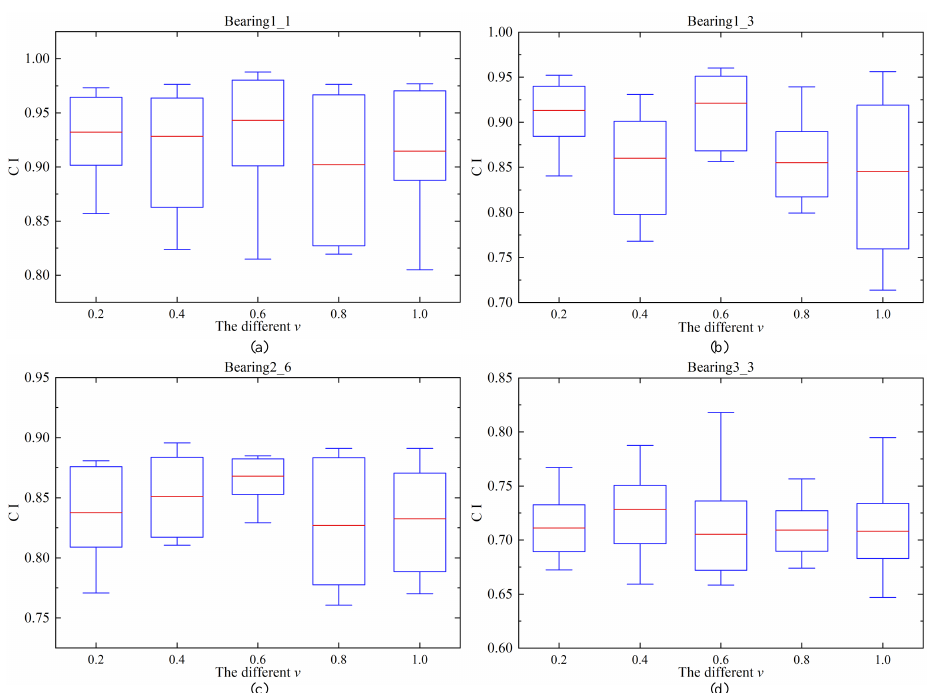
Figure 8. The results of the selection of different scale factors ν . ( a ) The result of Bearing1_1. ( b ) The result of Bearing1_3. ( c ) The result of Bearing2_6. ( d ) The result of Bearing3_3. After training the MSCAE using the training bearing data, the MSCAE was tested using testing bearings, and the HI extracted by four testing bearings is shown in Figure 9. In Figure 9, the green color indicates that the value of HI is closer to 1, and the blue color is closer to 0. The red curve is the HI trend curve fitted using polynomials. Four